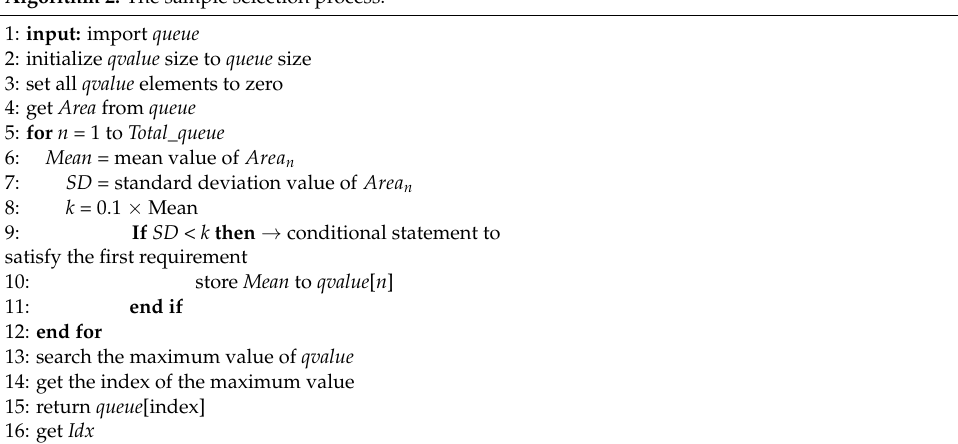
Algorithm 2. The sample selection process.